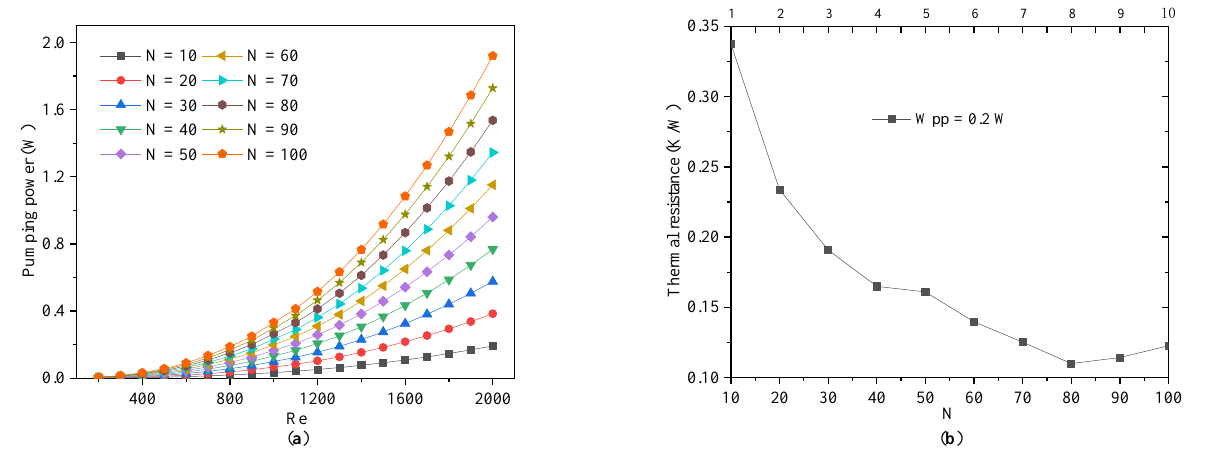
Figure 15. The variation of pump power consumed by MCHSs with different microchannel numbers as Reynolds number increases ( a ). The variation of thermal resistance with the number of channels at the same W pp ( b ).